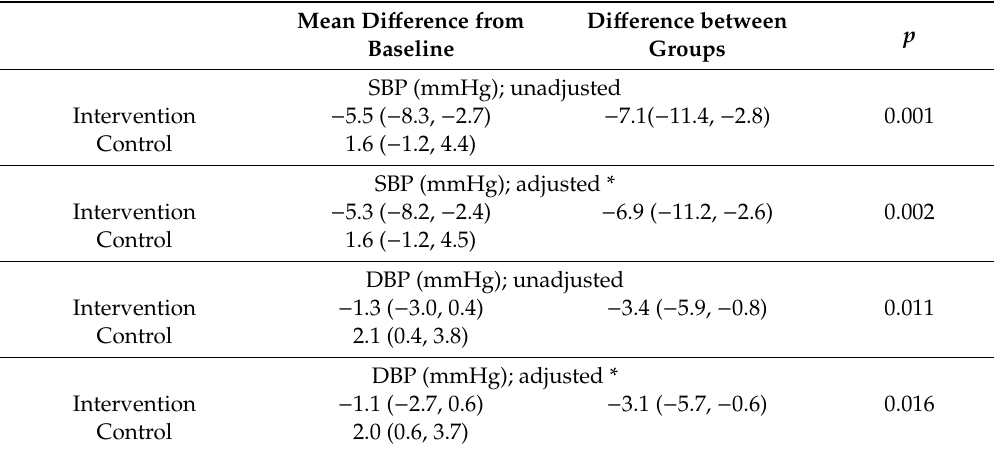
Table 2. Mean changes (95% CI) in SBP and DBP.